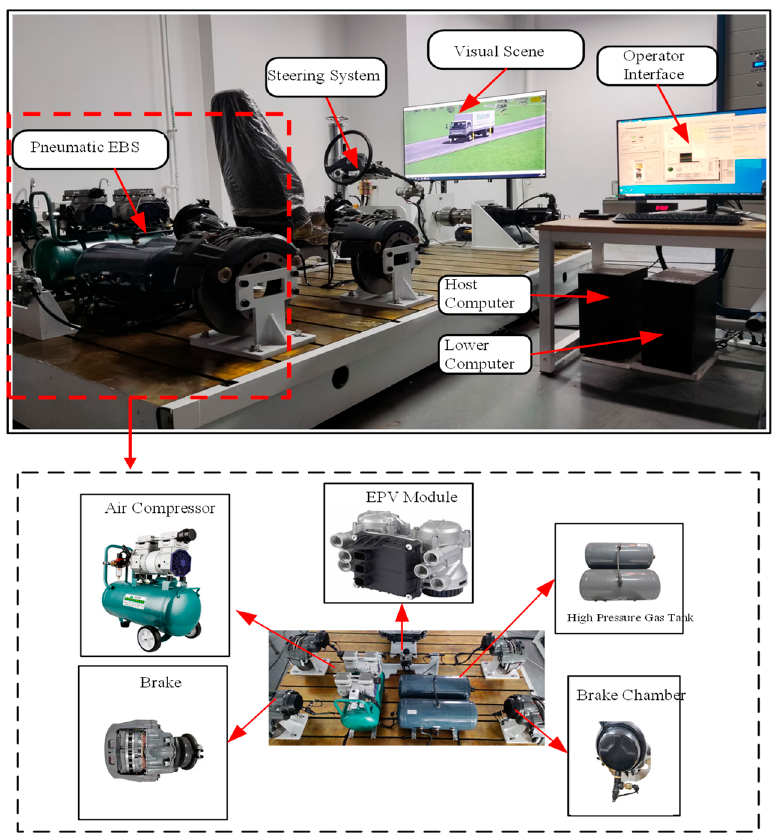
Figure 9. The performance simulation experiment platform of the braking system.